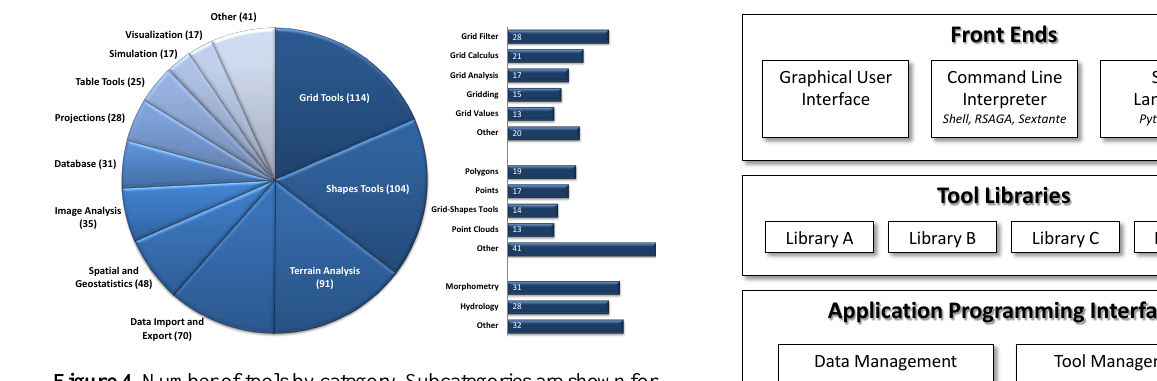
Figure 4. Number of tools by category. Subcategories are shown for the three largest groups: grid tools, shapes tools, and terrain analy- sis.